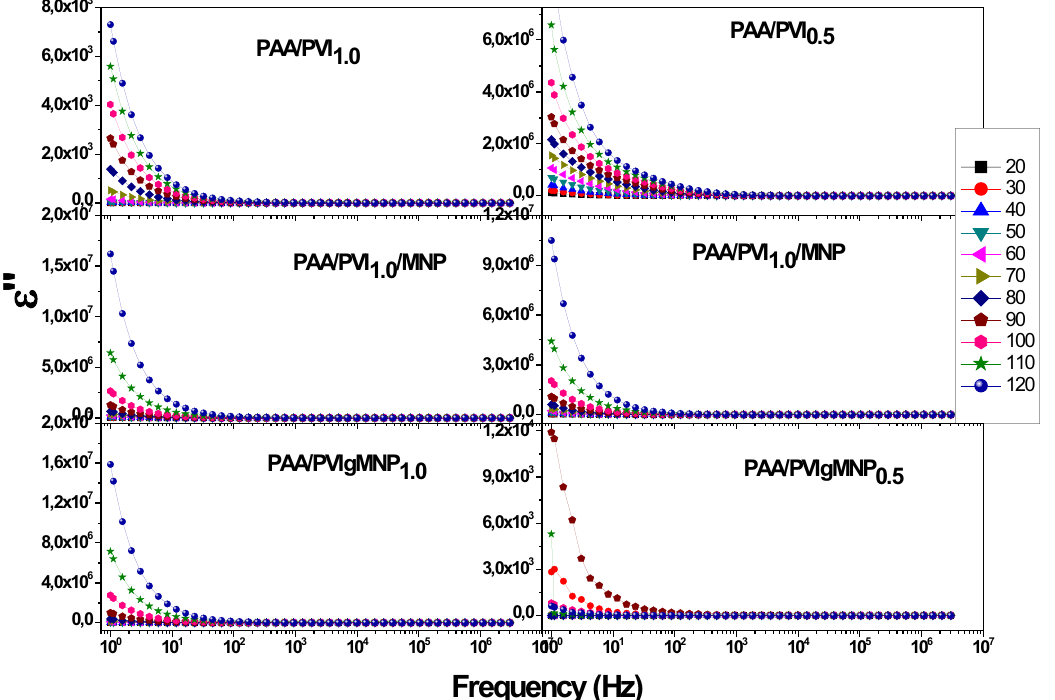
Figure 9. Imaginary part of Permittivity of A) PE1 B) PE2 C) NPE-1 D) NPE-2 E) NPE-3 F) NPE-4